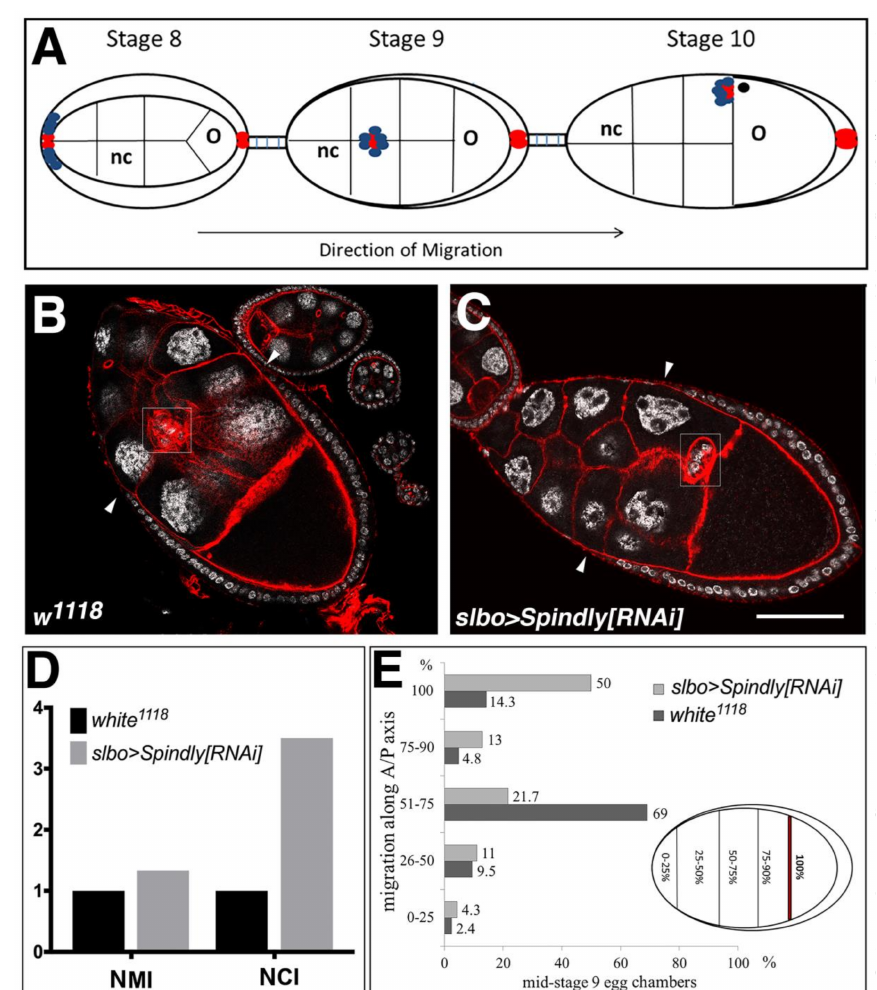
Figure 7. Spindly knockdown in migrating ovarian border cells. ( A ) Schematic drawing of border cell migration and outer follicle cells rearrangement. Egg chambers are depicted at stage 8–10 of oogenesis, where each egg chamber consists of 16 germ line cells (15 nurse cells (nc) and one oocyte (o)) and are surrounded by a layer of somatic follicle cells. At stage 8, polar cells (in red) at the anterior of the follicular epithelium recruit neighbouring cells (in blue) to form the migrating border cell cluster. At stage 9, the cluster delaminates from the epithelium and starts migrating posteriorly towards the oocyte and arriving at the nurse-cell-oocyte boundary at stage 10; ( B , C ) Immunostaining of stage 9 egg chambers from wild-type ( w 1118 ) ( B ) and slbo>Gal4;UAS>SpindlyRNAi females ( C ); (DAPI (grey), f-actin (red). Arrowheads indicate the border between squamous and columnar follicle epithelium; scale bar: 50 µ m; ( D ) Normalised migration index (NMI) and Normalised completion index (NCI) are indicated; for calculation see Materials and Methods; ( E ) Quantification of the phenotype described in ( B , C ). Premature border cell migration was observed in 50% of stage 9 egg-chambers ( n =